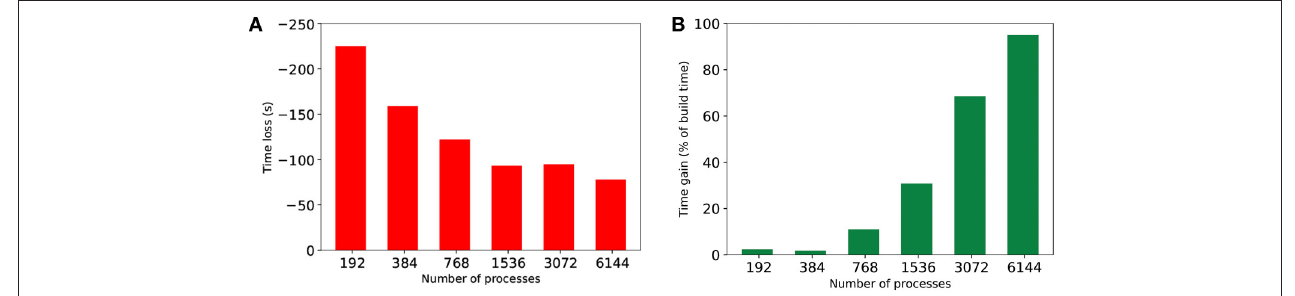
FIGURE 12 | Comparing the cost of computing hypergraph partitioning in extra build time (in seconds) (A) to the gains in simulation time by HP-NBX as a percentage of the build time (B) . Notwithstanding the gains on a 350 ms simulation are canceled out by the extra computing cost, the gains are expected to scale with the simulated time, whereas the cost is uniform for any given simulation time chosen and number of